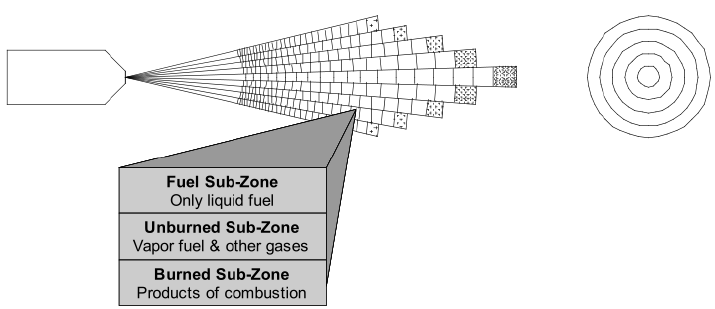
Figure 2. Schematic of the fuel zones distribution.